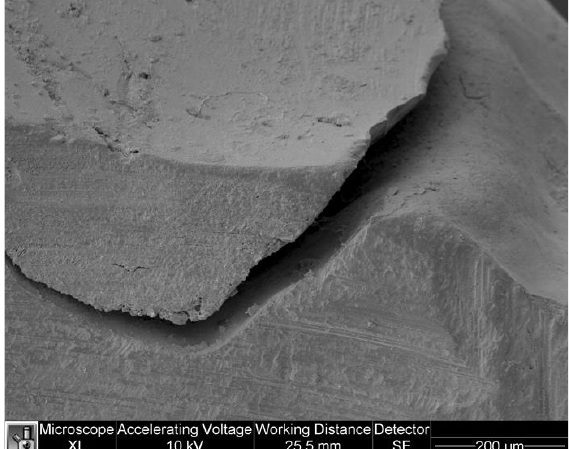
Figure 7. Marginal adaptation in a specimen of the study group.